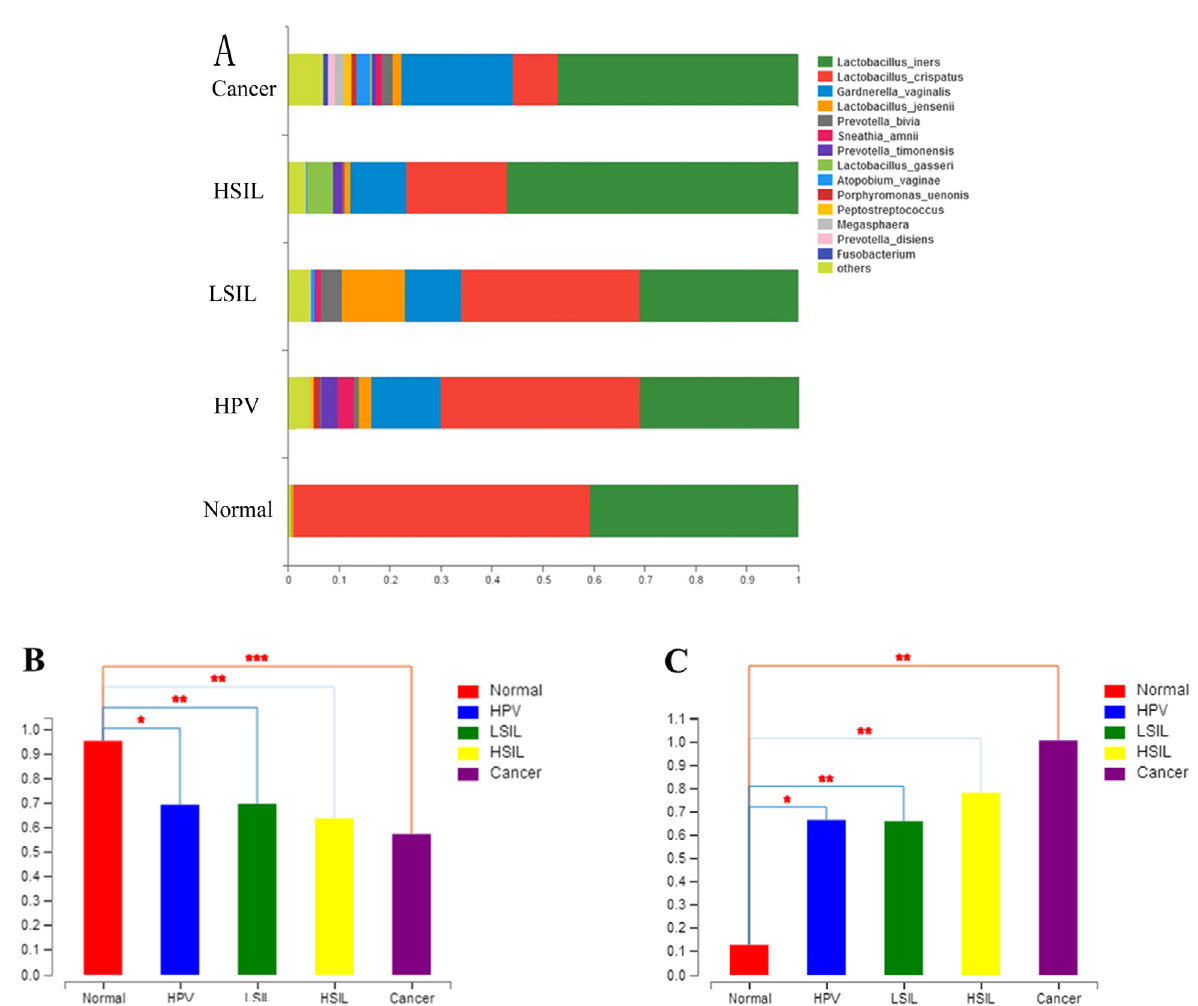
Figure 1 - The comparisons of the five groups in vaginal microbiota. (A) Bar chart describing the difference in bacterial diversity between the normal, HPV, LSIL, HSIL and cancer groups. (B) Simpson index of OTU level and P values calculated using Student`s t -test (P ≤ 0.05 was marked as *; 0.001 < P ≤ 0.01 was marked as **; P ≤ 0.001 was marked as ***). (C) Shannon index of OTU level and P values calculated using Student`s t -test (P ≤ 0.05 was marked as *; 0.001 < P ≤ 0.01 was marked as **; P ≤ 0.001 was marked as